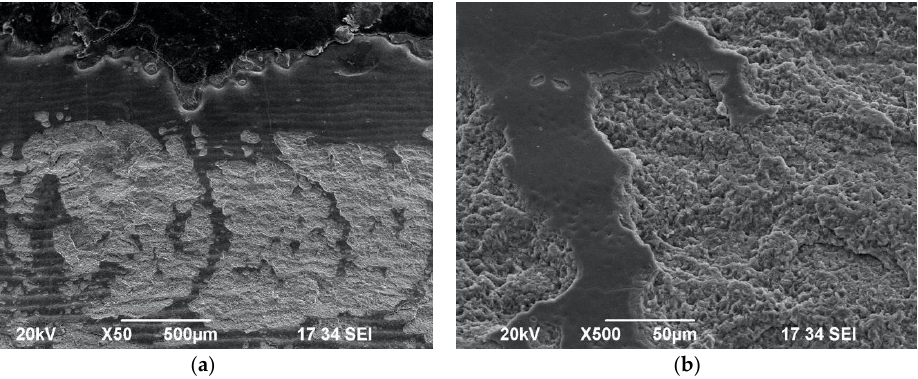
Figure 6. Figure 6. SEM images of enamel surface morphology following irradiation with 0.75 W/15 Hz/50 mJ/12 J/cm 2 without water spray—Group F—under ×50 magnification ( a ) and ×500 magnification 0.75 W/15 Hz/50 mJ/12 J/cm 2 without water spray—Group F—under × 50 magnification ( b ), showing scaly surface and wide-diameter impact craters. ( a ) and × 500 magnification ( b ), showing scaly surface and wide-diameter impact craters.